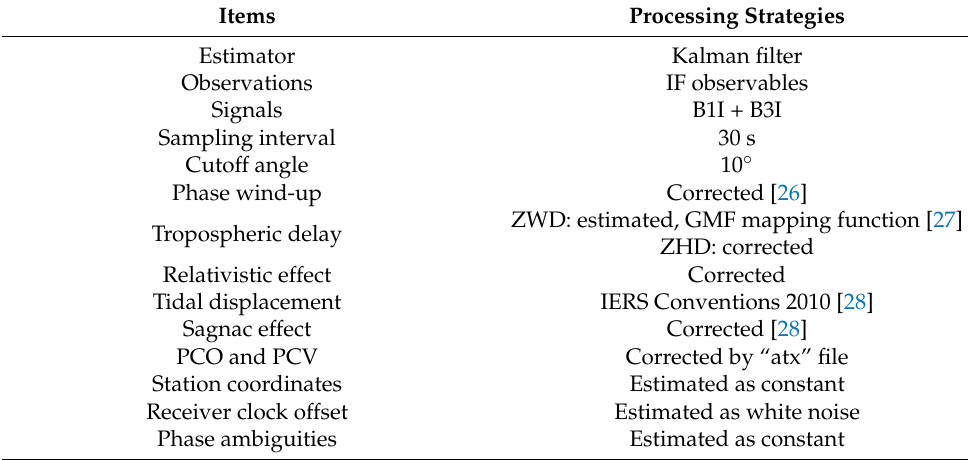
Table 2. Models used in data preprocessing.